Question: Produce a descriptive caption suitable for publication.
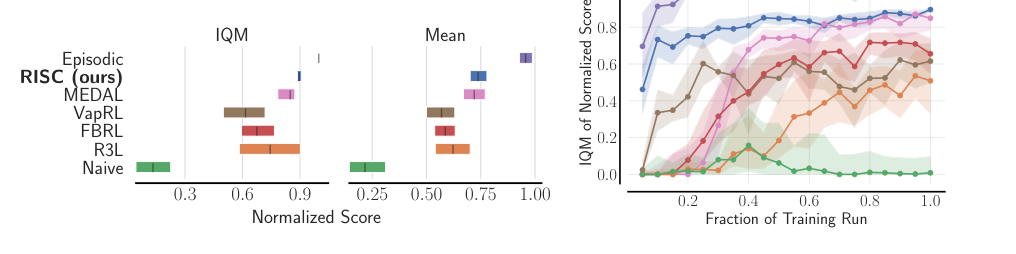
Answer: 95% confidence intervals for the interquartile mean (IQM) and mean normalized per- formance of RISC and other baselines aggregated across environments on the EARL benchmark (Tabletop Manipulation, Sawyer Door, Sawyer Peg, and Minitaur). Because MEDAL and VapRL require demonstrations and thus do not work on Minitaur, we exclude Minitaur from their calculations (left). IQM of RISC and other baselines on EARL benchmark as a function of progress through the training run. Shaded regions represent 95% confidence intervals (right). RISC outperforms and learns much faster than other reset-free baselines.